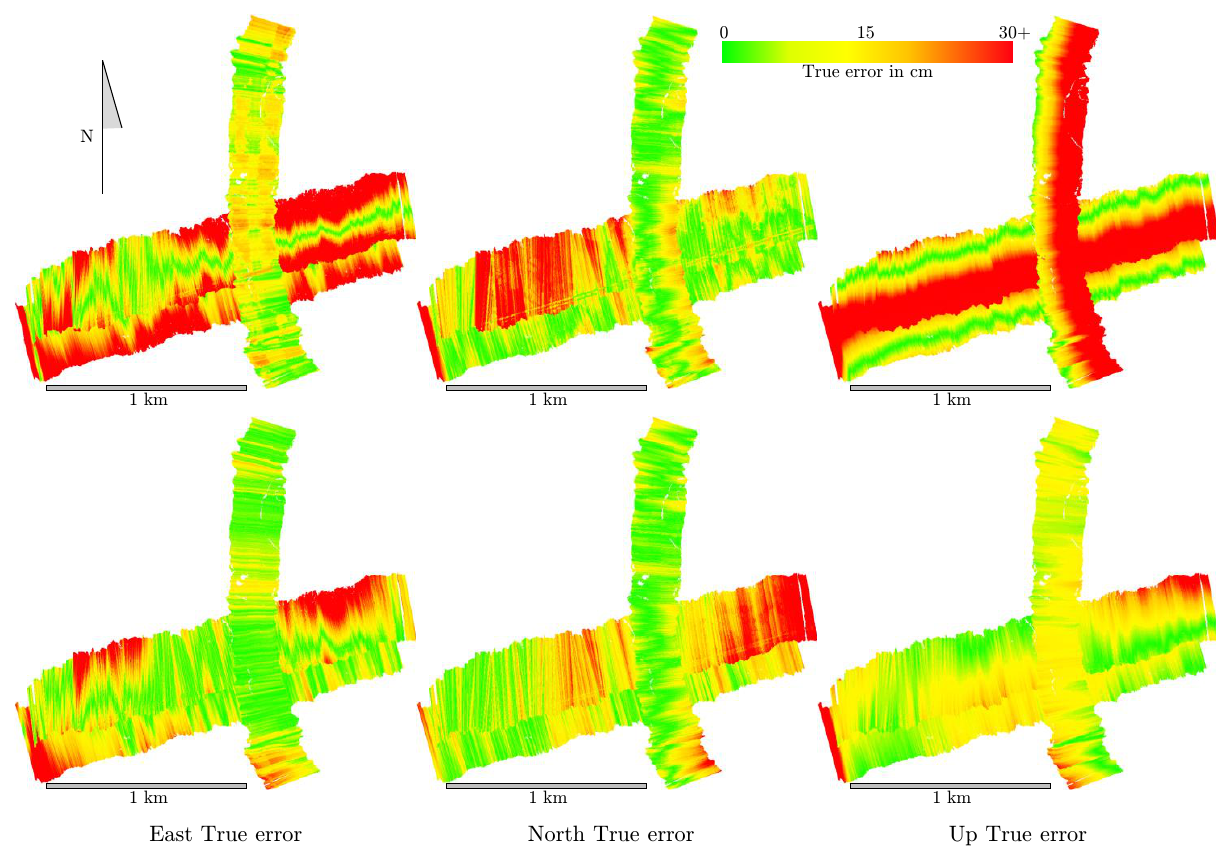
Figure 4. Difference between the generated point-cloud and the Ground Truth in East, North and Up produced using the trajectory of the consumer Grade IMU without (first row) and with (second row) fusion with photogrammetry. The reference point-cloud data permits the simulation of 27 links between LIDAR measurements and image observations (corresponding on the terrain to the blue dots on Figure